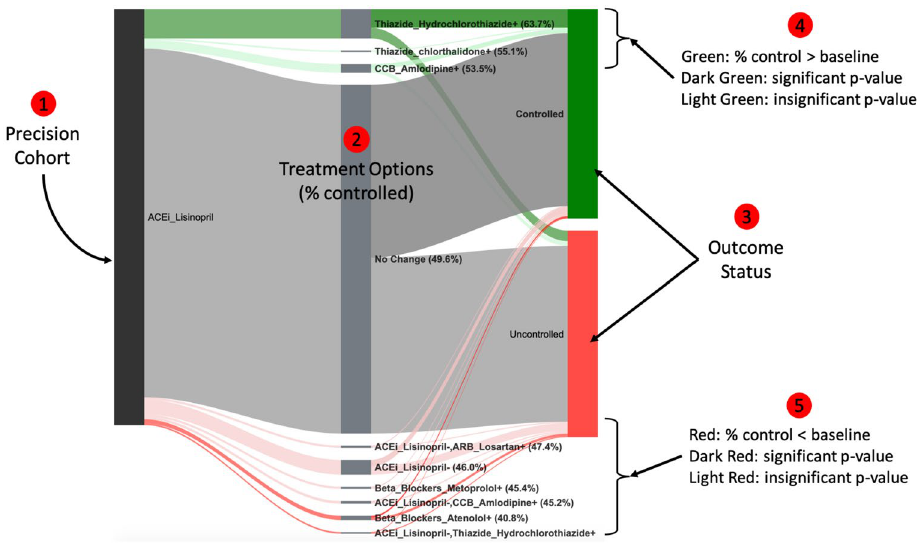
Figure 4. Personalized treatment options and associated outcomes in a precision cohort using a Sankey diagram. (1) The initial node (black) represents all decision points in the precision cohort for the individual patient of interest who has an HTN diagnosis, is over age 65, and is on Lisinopril (ACEI). (2) Each pathway leaving the initial node is a different treatment decision that is observed in the data. The thickness of the edge is proportional to the number of decision points. The label contains the medication class and ingredient, the start or stop of the medication (“+” or “−” suffix), and the percentage (in parentheses) of decision points under control in the follow-up. The “no change” or “stay the current course” treatment option is shown in gray and is considered the “baseline” treatment option. (3) The terminal nodes represent the outcome for the disease condition under control (green) and not under control (red). (4) Treatment options associated with better control than the baseline are shown as green pathways above the baseline with dark green indicating statistical significance. (5) Treatment options associated with worse control than the baseline are shown as red pathways below the baseline with dark red indicating statistical